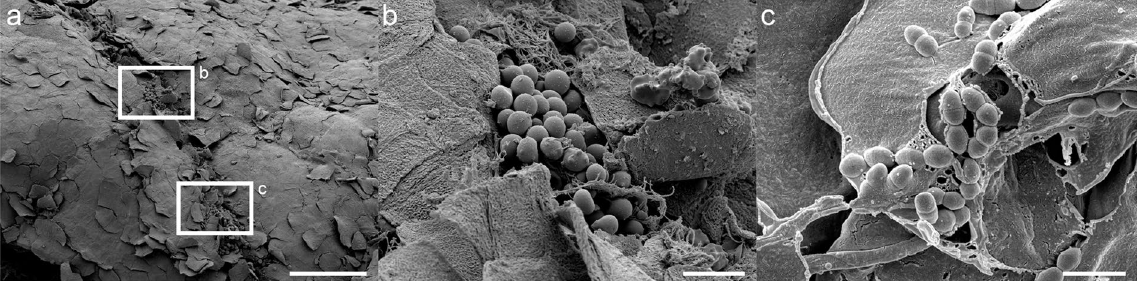
Figure 1. The presence of bacterial biofilm at lesional AD skin colonized with S . aureus . Biofilm observed by scanning electron microscopy on the stratum corneum of an AD patient. ( a ) Microbial biofilm on skin of an AD patient colonized with S . aureus . The high magnification pictures in figures b and c are derived from the area in box b and c . Scale bar 100 μ m. ( b ) Biofilm composed of intricate extracellular matrix material and bacteria. Scale bar 10 μ m. ( c ) High magnification view visualizing individual bacteria surrounded by extracellular matrix material observed between corneocytes on AD skin. Scale bar 2 μ